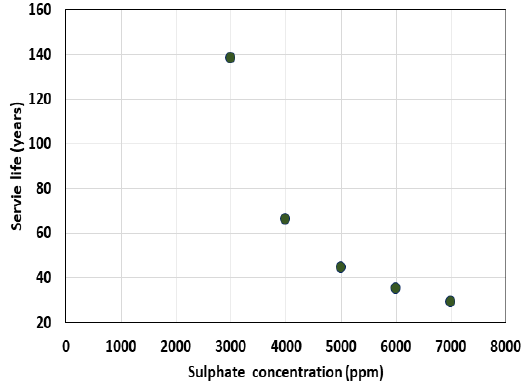
Figure 8. Sulfate ion profile after 50 years. Figure 9. Service life variation with exterior conditions. Figure 9. Service life variation with exterior conditions. 230